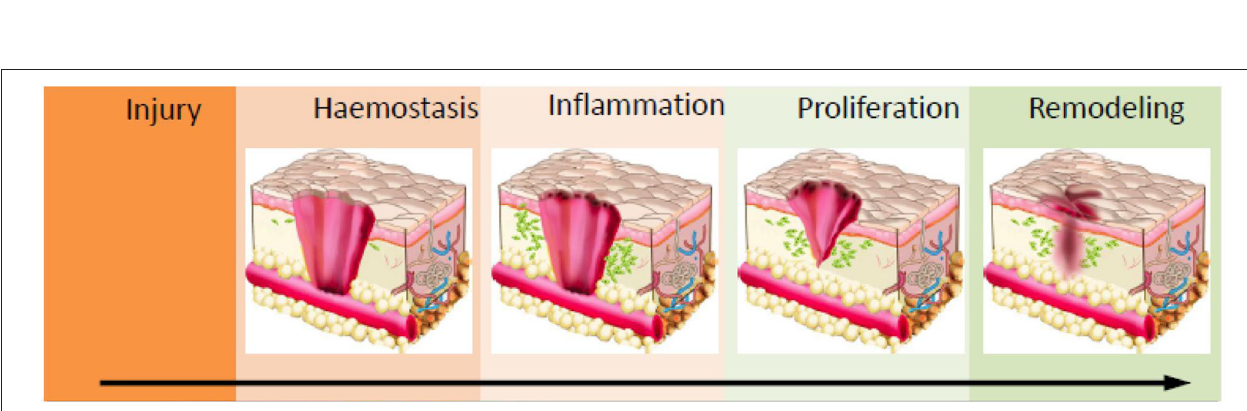
FIGURE 2 | Schematic of the wound healing process. Haemostasis via coagulation and clot formation occurs at the wounded site followed by immune cells infiltration and inflammation to clean up the site of injured tissue. This prevents infection and triggers granulation. In the proliferation phase, fibroblast, epithelial cells, keratinocytes and endothelial cells will migrate and proliferate into wounds to deposit ECM proteins and other biomolecules which enables wound closure. Ultimately, in the maturation/remodelling phase, ECM deposition and clearance controls the development of scar formation. Reprinted with permission from Lin et al. (2018). Copyright 2018,